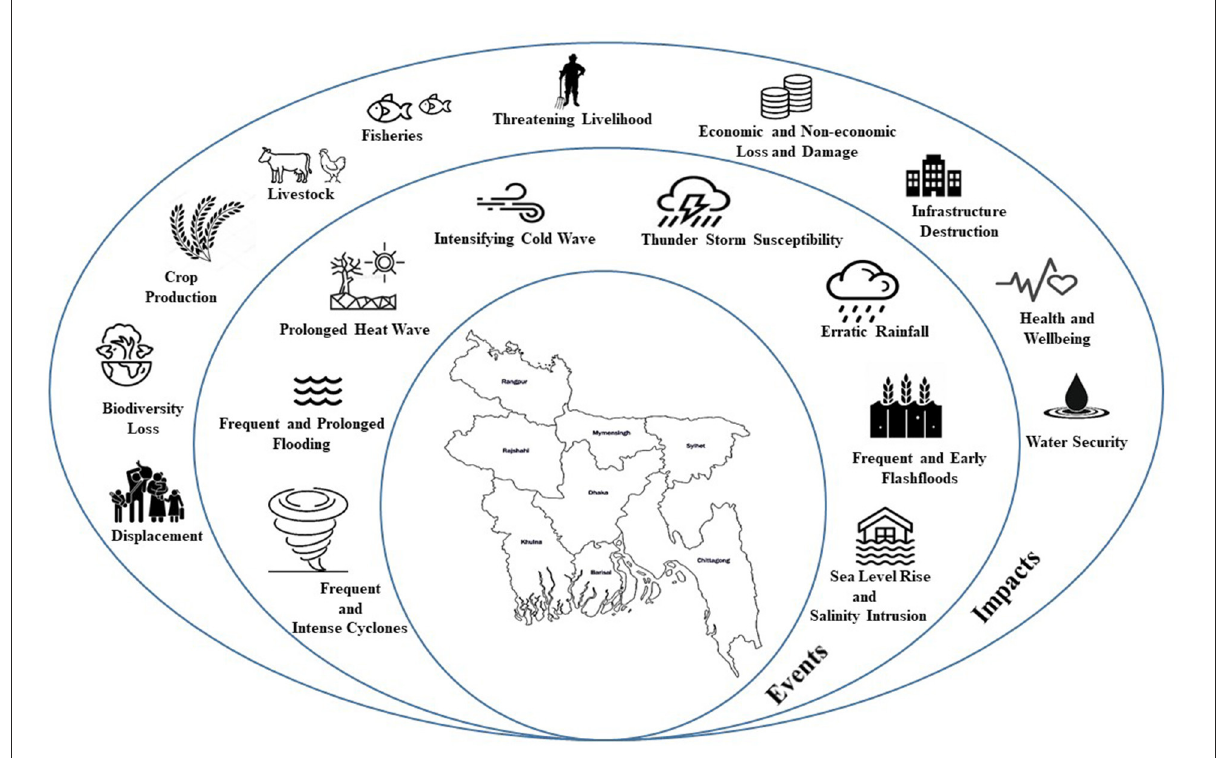
FIGURE2 Climate change induced extreme events and their impacts in Bangladesh.